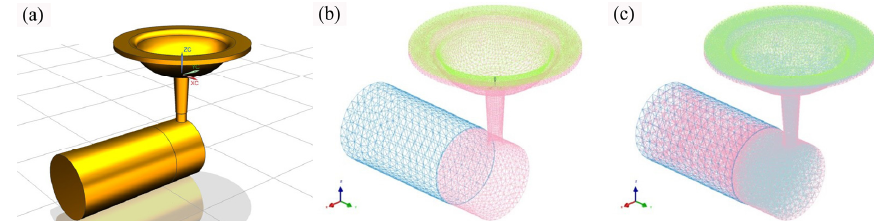
Figure 2. Schematic of forming mold.